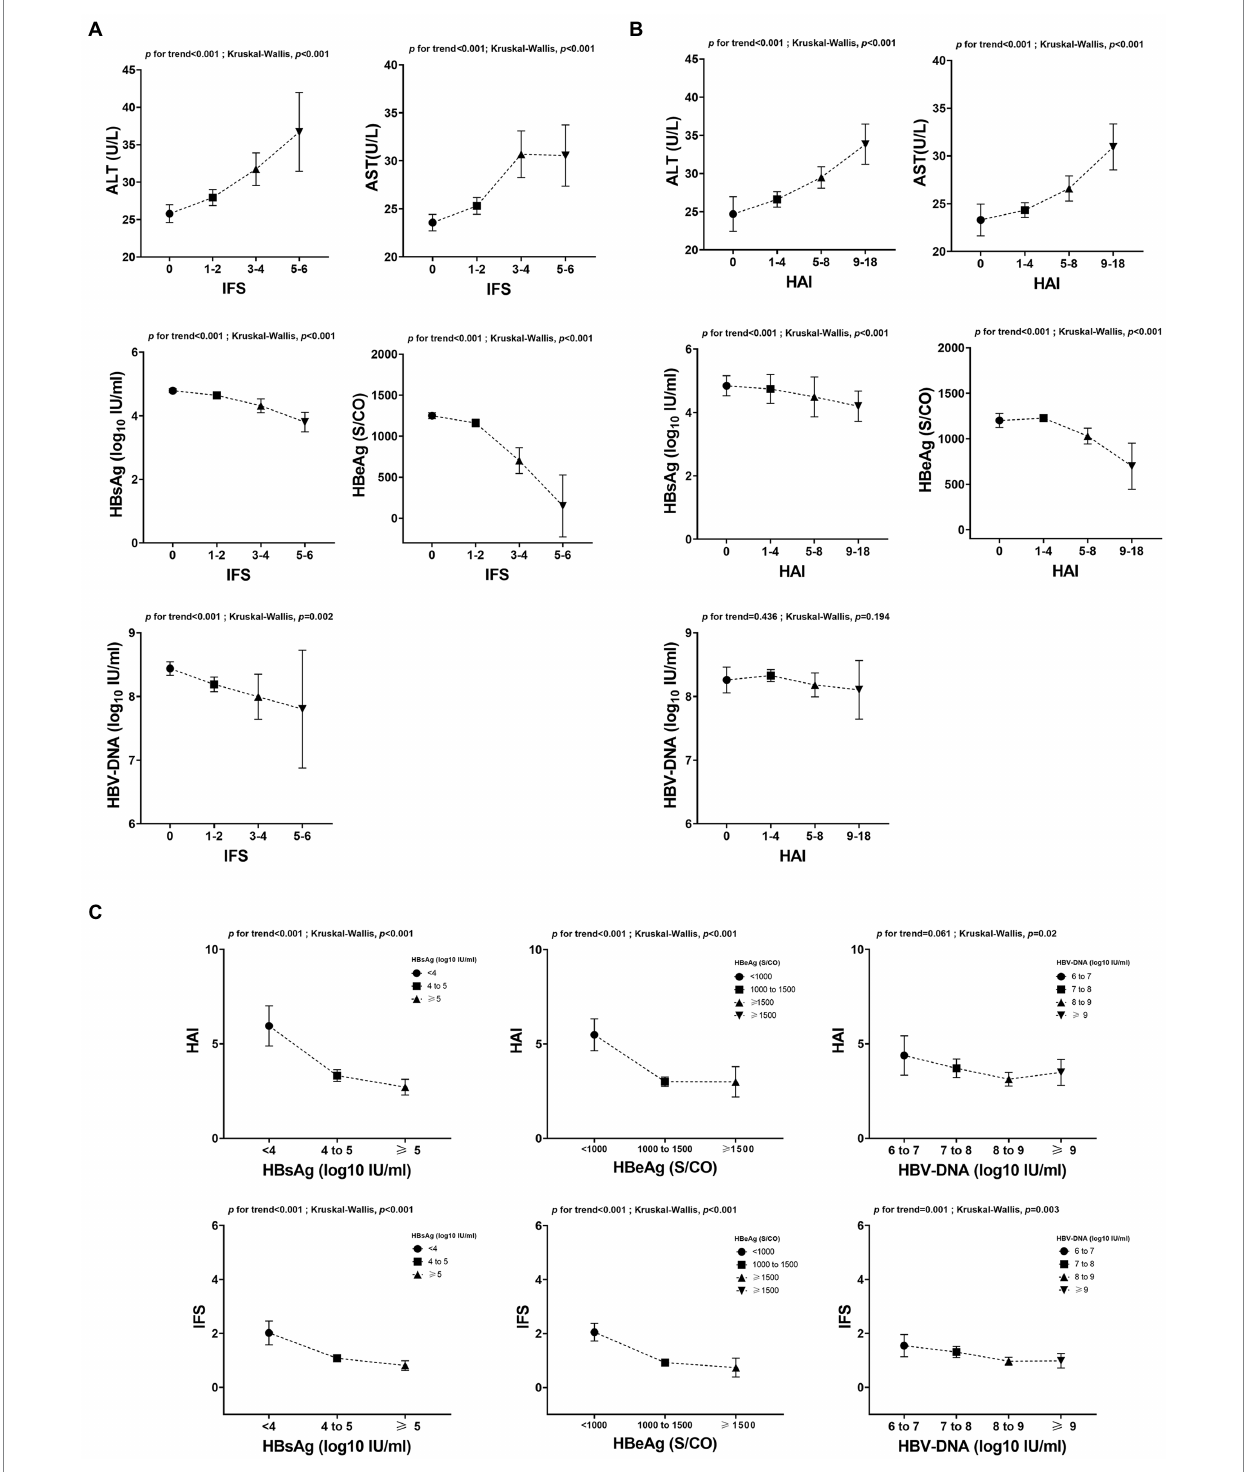
FIGURE 4 Relationship between serological indicators and liver pathology. (A) Relationship between serological indicators and the extent of fibrosis. (B) Relationship between serological indicators and the extent of inflammation. (C) Relationship between liver pathology and different levels of virological indicators. ALT, alanine aminotransferase; AST, aspartate transaminase; HAI, histology activity index; HBeAg, hepatitis B e-antigen; HBsAg, hepatitis B surface